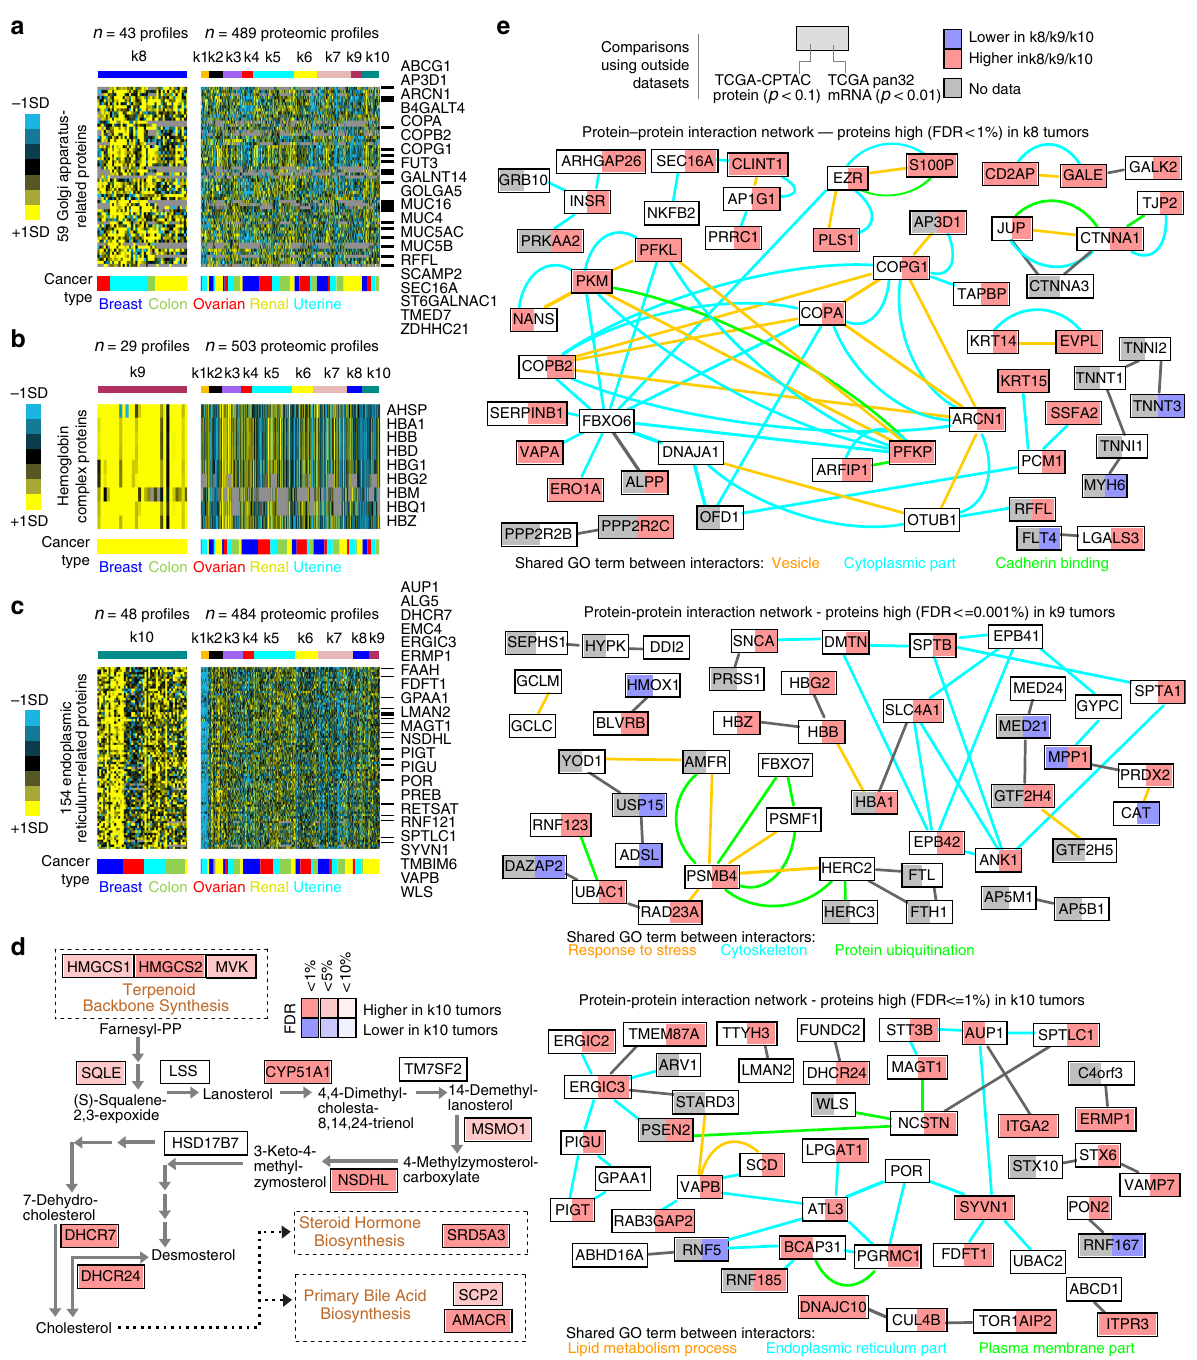
Fig. 7 Overview of k8, k9, and k10 proteome-based subtypes. a For a set of 59 Golgi apparatus-related proteins elevated in the k8 subtype (FDR < 5%), heat maps of differential protein expression patterns (expression values normalized within cancer type; SD, standard deviation from the median), across CPTAC Con fi rmatory/Discovery proteomic pro fi les ordered by subtype. Listed proteins are the subset highest in k8 over all other subtypes. b For a set of nine hemoglobin complex proteins elevated in the k9 subtype (FDR < 1%), heat maps of differential protein expression patterns, across CPTAC Con fi rmatory/Discovery proteomic pro fi les ordered by subtype. c For a set of 154 endoplasmic reticulum-related proteins elevated in the k10 subtype (FDR < 1%), heat maps of differential protein expression patterns, across CPTAC Con fi rmatory/Discovery proteomic pro fi les ordered by subtype. Listed proteins are those among the top 50 most over-expressed for the k10 subtype. d Diagram of steroid biosynthesis pathway and associated proteins (from KEGG database 48 ). Red denotes signi fi cantly higher expression in the k10 subtype. e Protein – protein interaction networks involving the top proteins over- expressed in k8 tumors (top network), the top proteins over-expressed in k9 tumors (middle network), and the top proteins over-expressed in k10 tumors (bottom network). Nodes represent proteins that were found over-expressed in the given subtype. Nodes are colored according to patterns of differential expression in additional cohorts (left, protein data from CPTAC-TCGA cohort; right, mRNA data from TCGA pan32 cohort). A line between two nodes signi fi es that the corresponding protein products of the genes can physically interact (according to the literature, from Entrez gene interactions database). Colored edges (other than gray) denote a common GO term annotation shared by both of the connected proteins. FDR false discovery